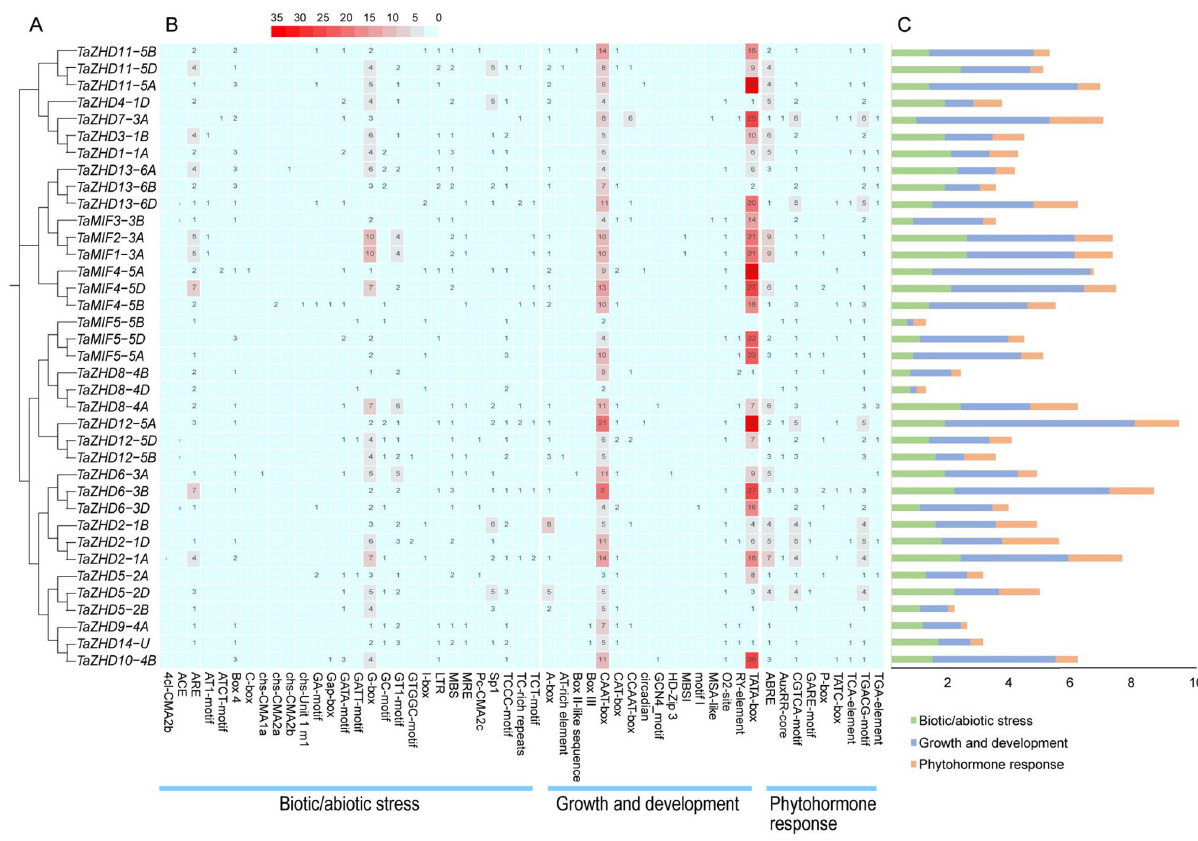
Fig 3. Analysis of cis -acting elements in the promoter sequences of TaZF-HD genes. ( A ) Phylogenetic analysis of wheat ZF-HD family; ( B ) Cis- acting elements in the promoters of TaZF-HD genes. The different colors and numbers of grids indicate the numbers of different promoter elements. ( C ) The histograms of different colors represent the sum of the cis- acting elements in each category.